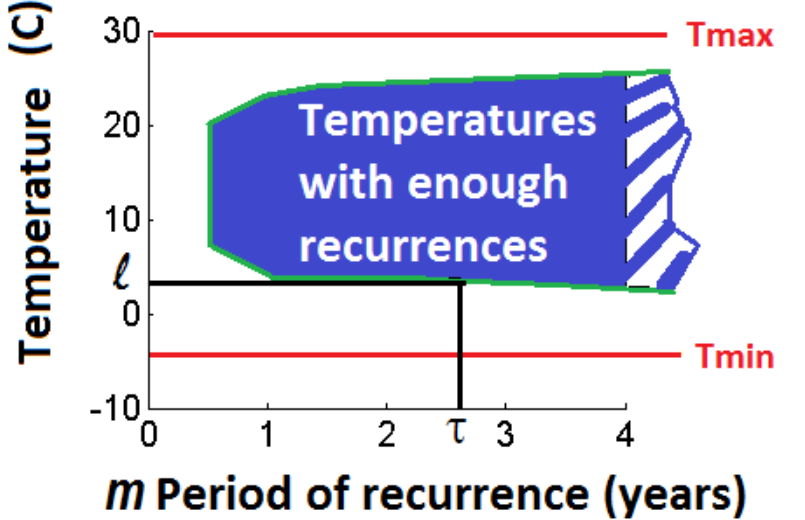
Figure 1. After Faranda and Vaienti [29]. Region of temperature for which the hypothesis that minima of | T ∗ − T ( t ) | are GEV distributed is not rejected (blue area) for different period of recurrences m in years. Return times τ and corresponding return levels (cid:96) are represented by the projections of the green curve on the axis. Red lines are the absolute extremes of the series, indicated as global maximum and global